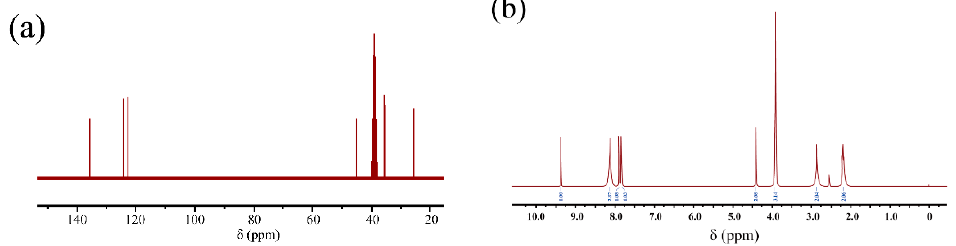
Figure 3. 13 C NMR spectra ( a ) and 1 H NMR spectra ( b ) of [NH 2 C 3 bim][Br].